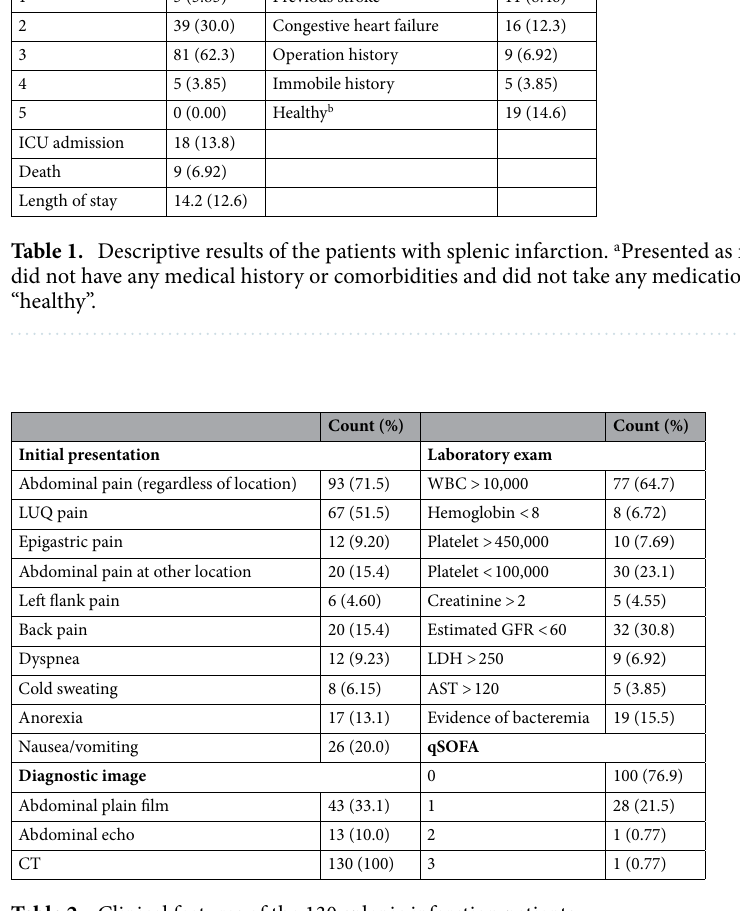
Table 2. Clinical features of the 130 splenic infarction